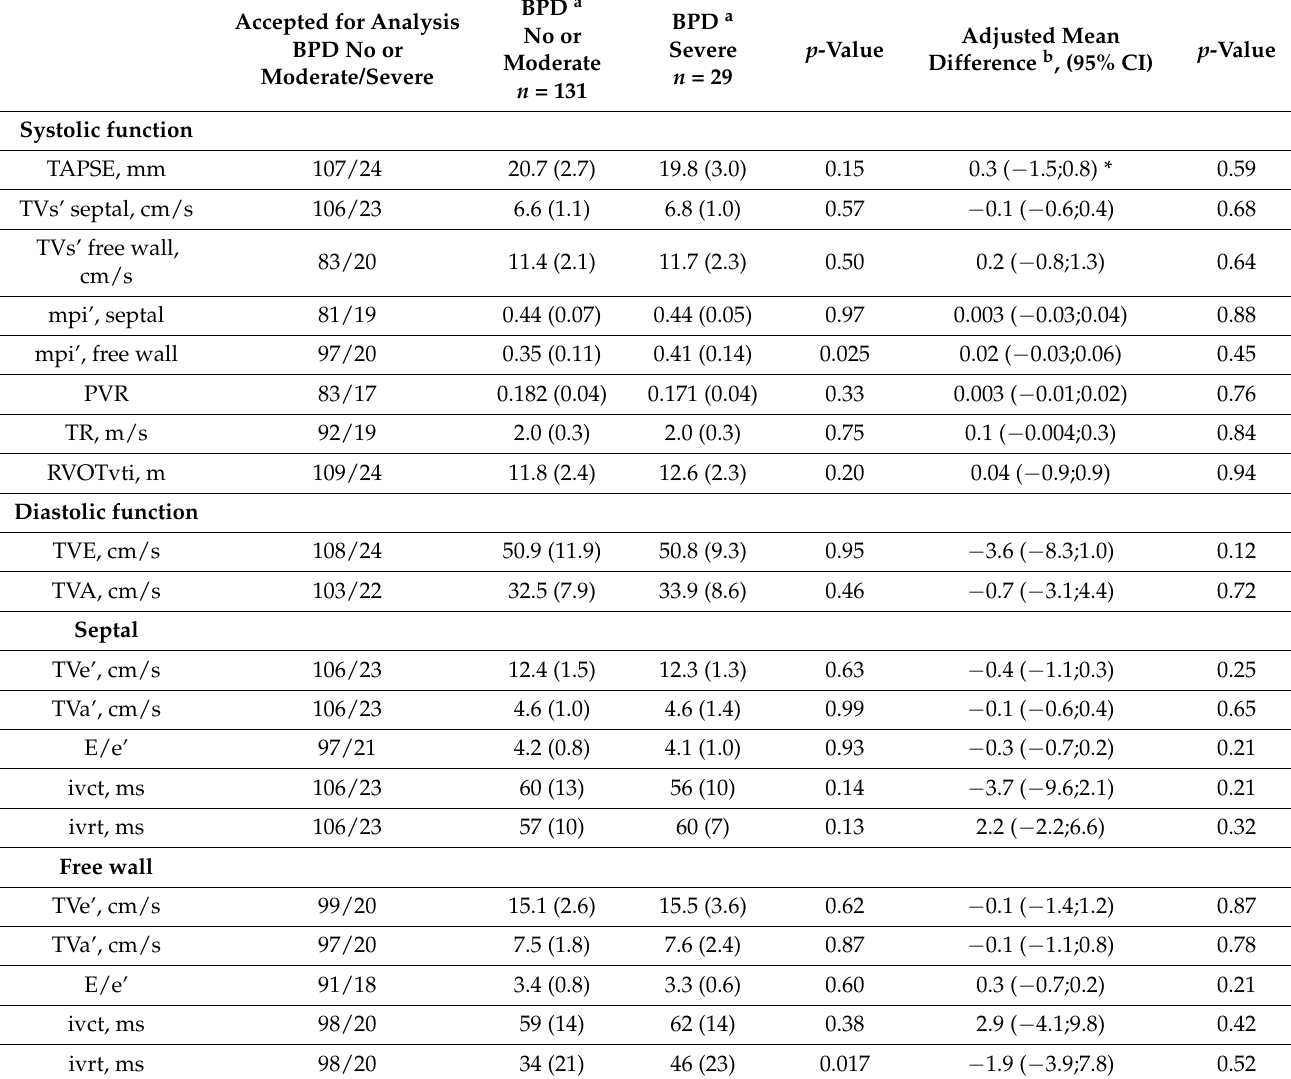
Table 7. Right heart systolic and diastolic function in 6.5-year-old children born extremely preterm (EXPT) stratified by neonatal diagnosis of no or moderate bronchopulmonary disease (BPD) versus severe